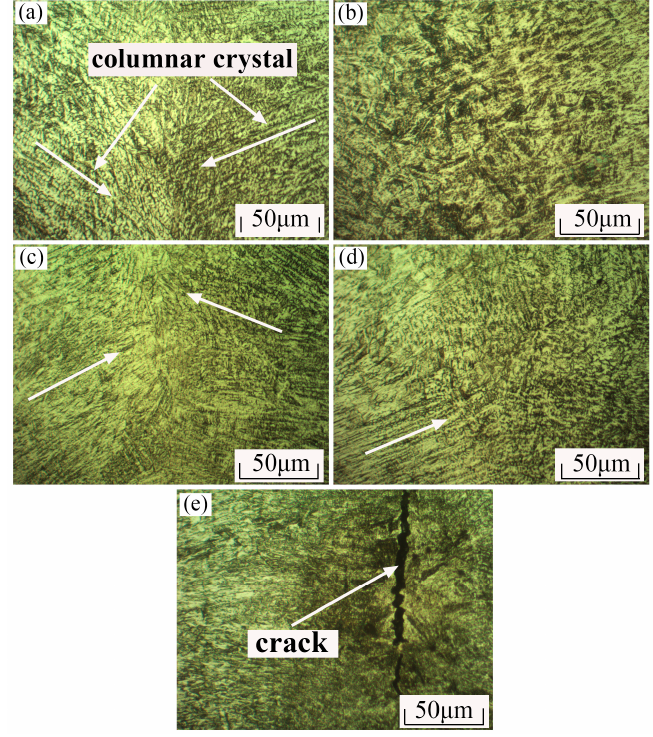
Figure 7. Microstructure in the center of the weld seam with different welding speed: ( a ) 0.4 m/min; ( b ) 0.6 m/min; ( c ) 0.8 m/min; ( d ) 1.0 m/min; ( e ) 1.2 m/min.